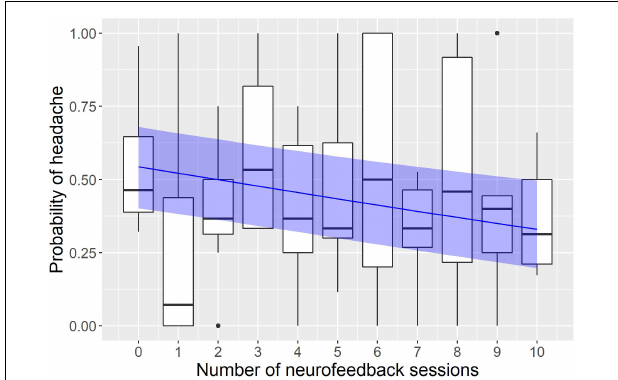
FIGURE 1 | Modeling of the influence of neurofeedback on the headache probability. The x axis represents the number of neurofeedback sessions the subject had to date; the y axis represents the probability to have a headache on a given day. Observed probabilities are shown by boxplots in black (the lower and upper hinges correspond to the first and third quartiles; the bold horizontal line corresponds to the median; the whiskers extend to the largest value no further than 1.5 inter-quartile range from the hinge; outliers are shown by dots). The probability predicted by the model is indicated by the blue line with a ribbon representing 95% confidence interval.